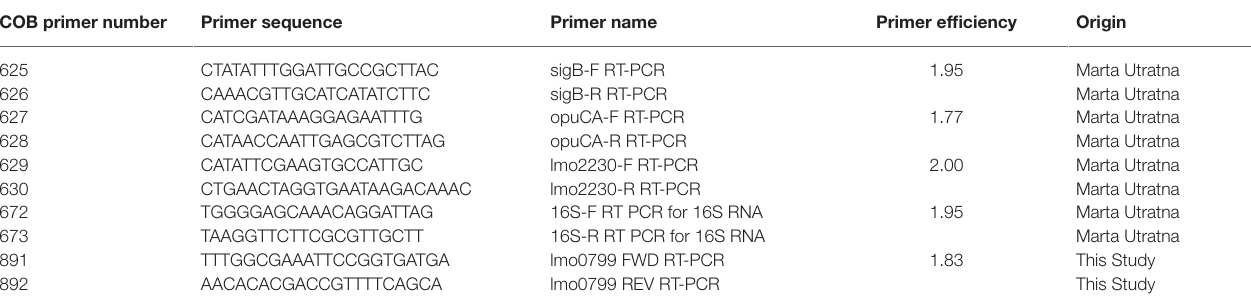
TABLE 2 | RT-PCR primers and their corresponding efficiencies used in this study. COB primer number Primer